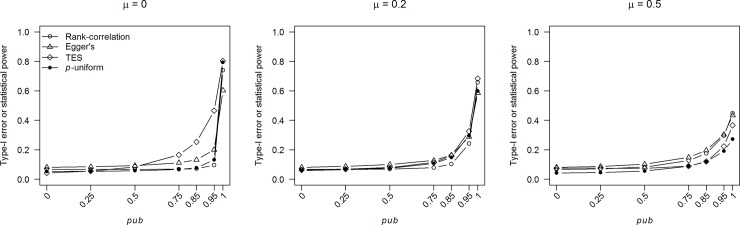
Type-I error rate and statistical power of the rank-correlation test (open bullets), Egger’s test (triangles), test of excess significance (TES; diamonds), and p-uniform’s publication bias test (solid bullets) in the Monte-Carlo simulation study.pub and μ are the extent of publication bias and the average true effect size, respectively.